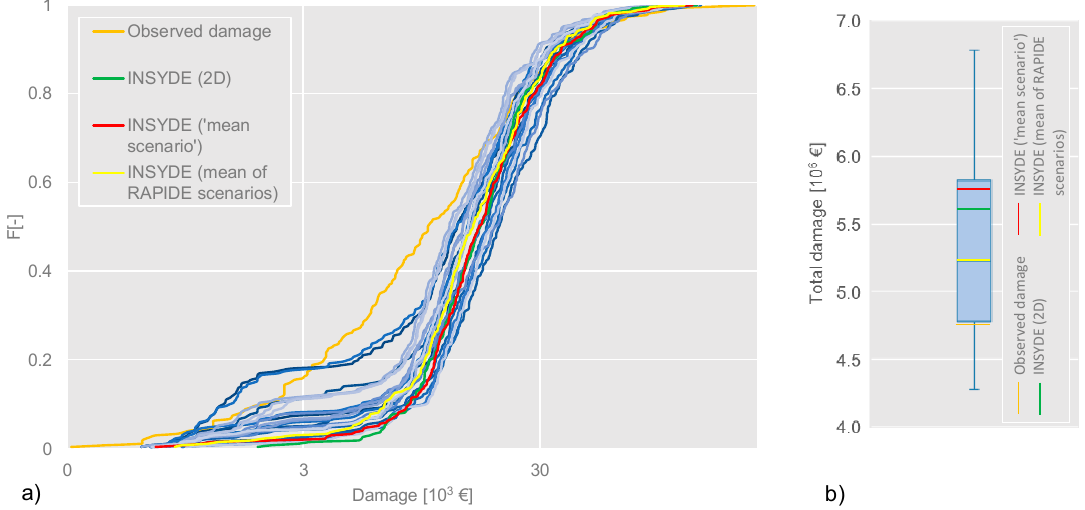
Figure 9. Results of damage modelling (loss data updated to year 2013). ( a ) Cumulative density functions of simulated (green: 2D model; shades of blue: RAPIDE; red: ‘mean scenario’ of RAPIDE; yellow: mean damage calculated from RAPIDE scenarios) versus observed losses for the different tested hazard configurations. ( b ) Boxplot of total damage calculated for the different configurations generated in the sensitivity analysis of RAPIDE (blue with yellow mean), together with the total damages for the other estimates.